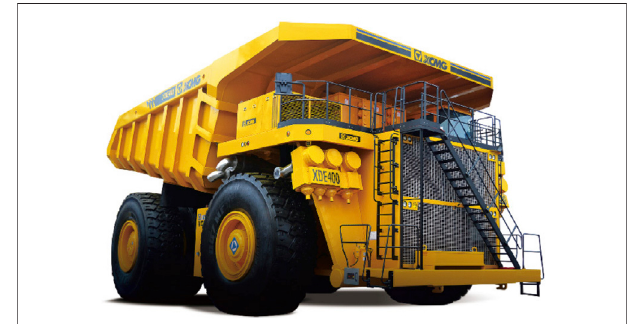
FIGURE 1 | A mining truck of